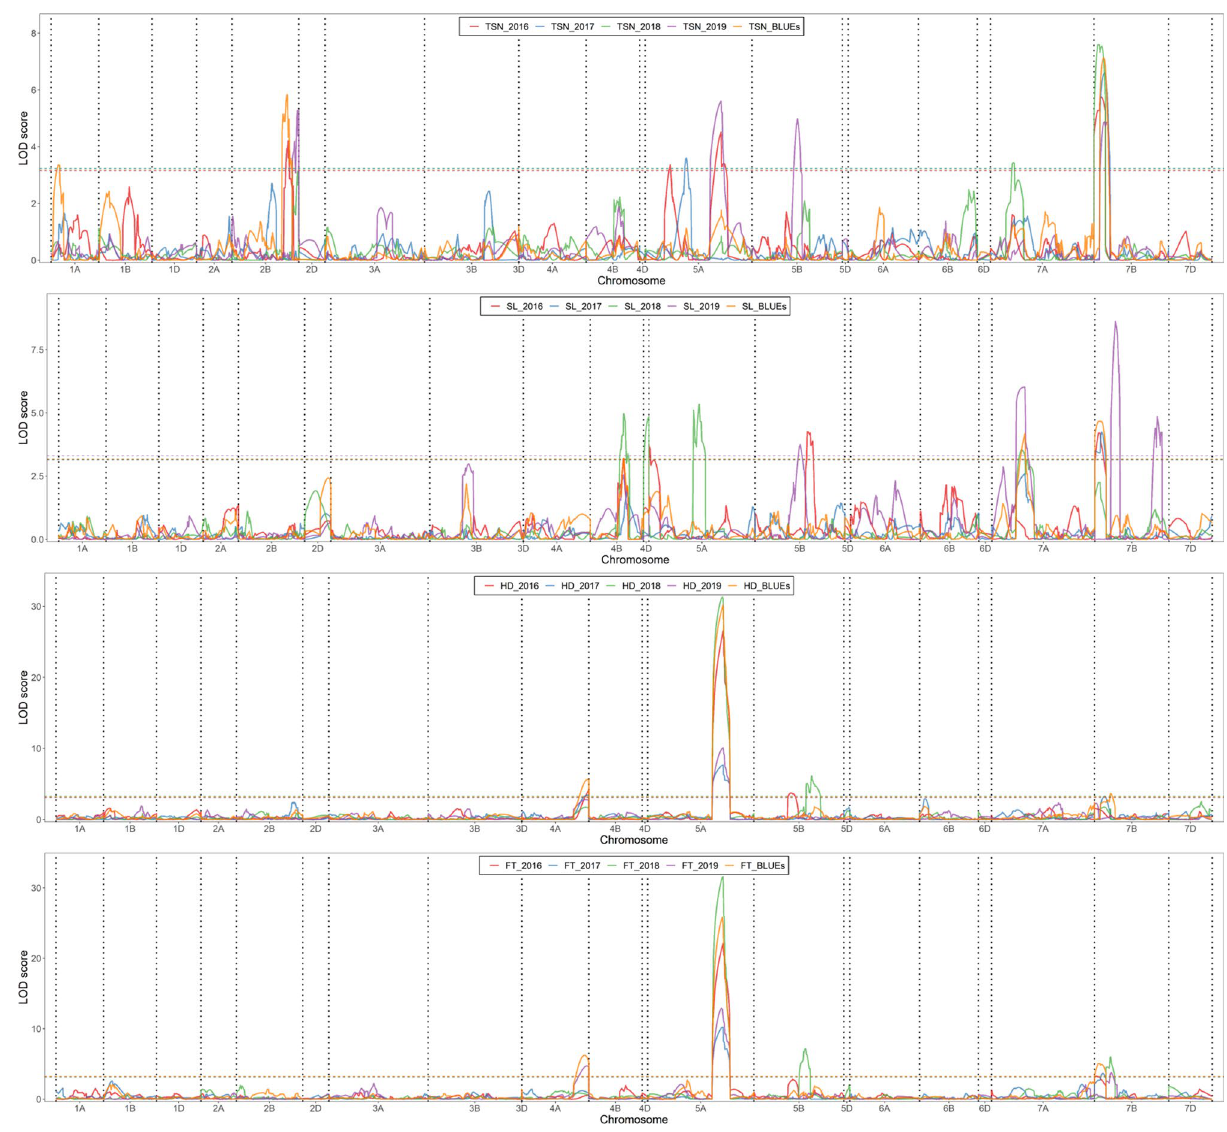
Figure 3. Quantitative trait loci (QTL) map of total spikelet number (TSN), spike length (SL), heading date (HD), and flowering time (FT) in a DH-population of spring wheat grown over 4 years and their corresponding best linear unbiased estimations (BLUEs). The horizontal dashed lines indicate the corresponding logarithm of odds (LOD) threshold estimated at α = 0.05 with 1000 permutations to assess the QTL significance.